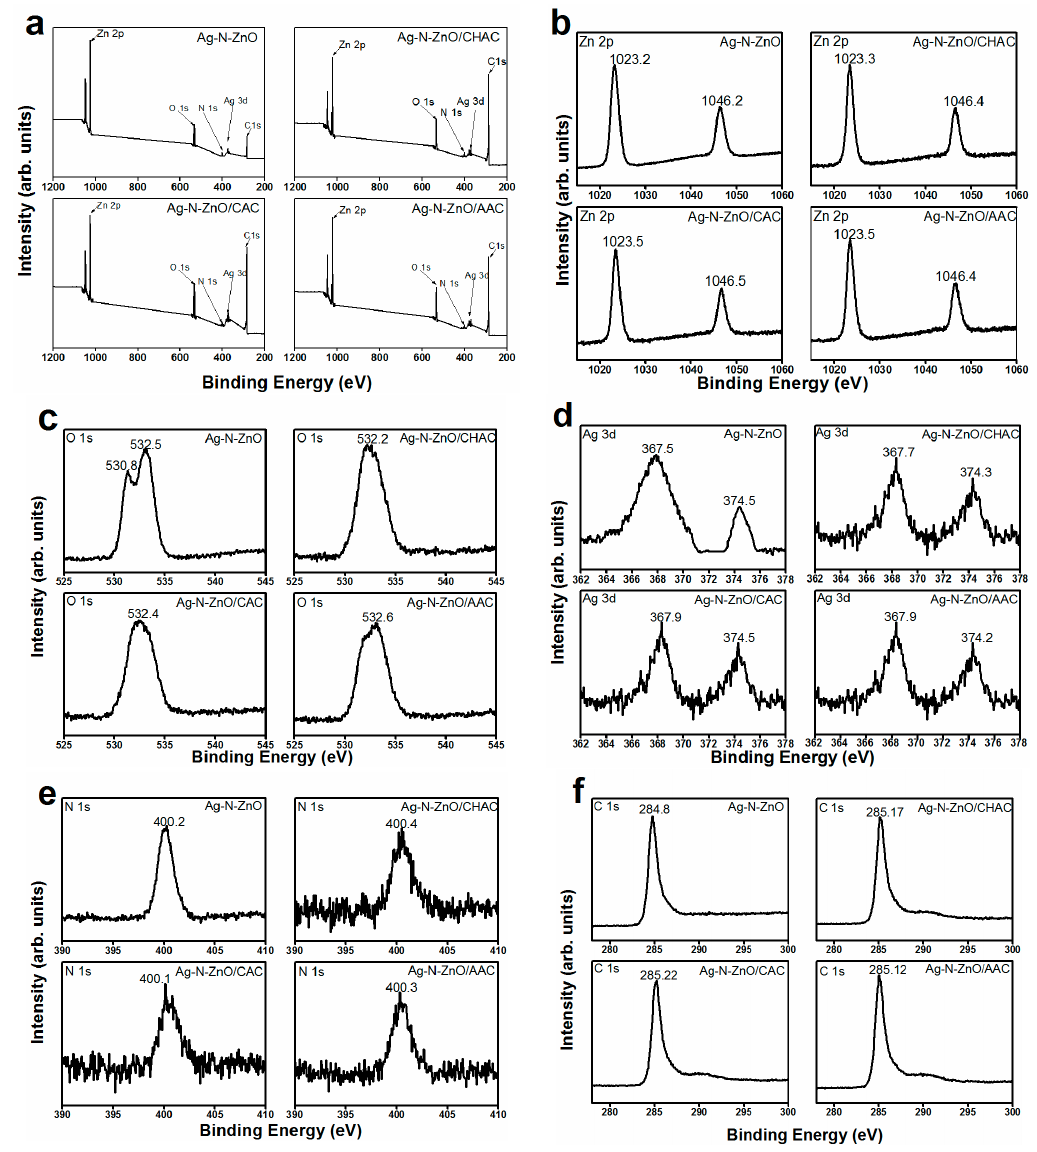
Figure 5. XPS spectra of survey spectra ( a ) Zn 2p ( b ), O 1s ( c ), Ag 3d ( d ), N 1s ( e ) and C 1s ( f ) levels of Ag-N-ZnO, Ag-N-ZnO/CHAC, Ag-N-ZnO/CAC and Ag-N-ZnO/AAC.